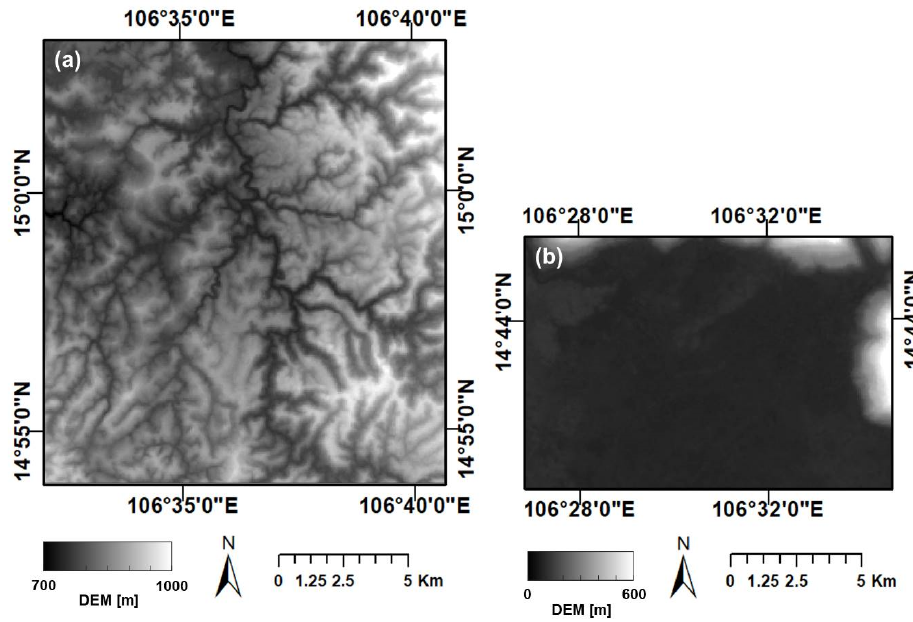
Figure 2 . DEM images at ( a ) Xe-Namnoy reservoir, ( b ) Hinlat area. Figure 2. DEM images at ( a ) Xe-Namnoy reservoir, ( b ) Hinlat